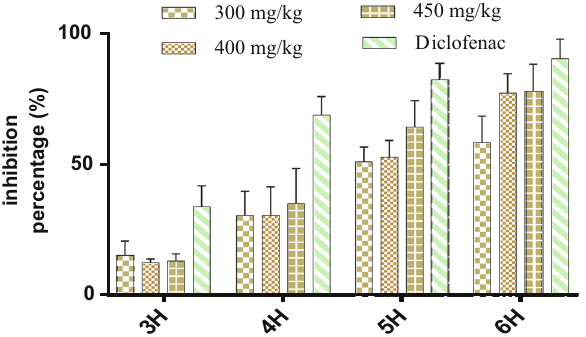
Figure 4: E ff ect of W. frutescens extract administered orally at di ff erent doses and 1% Diclofenac on carrageenan - induced edema in rats. Values are expressed as average ± SEM.